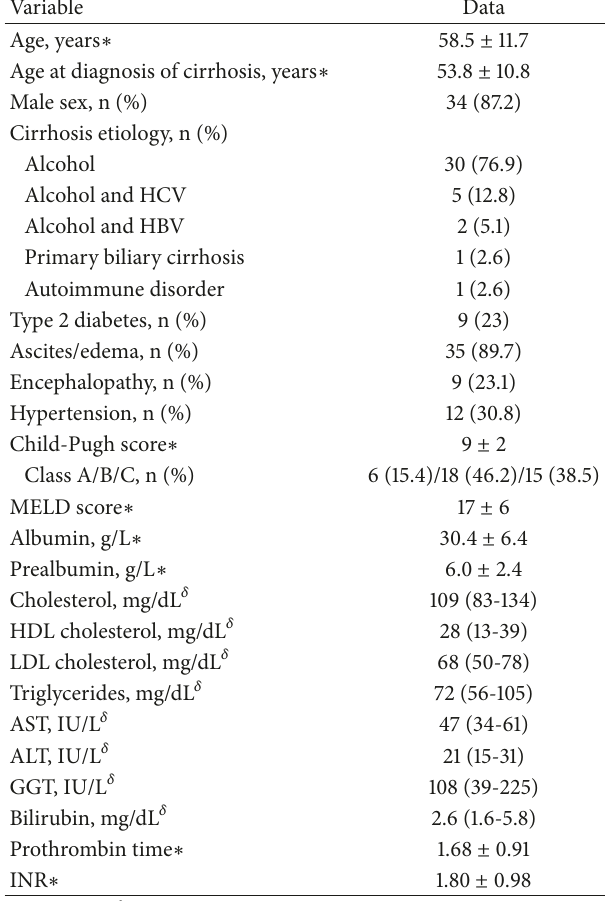
Table 1: Clinical characteristics of cirrhotic